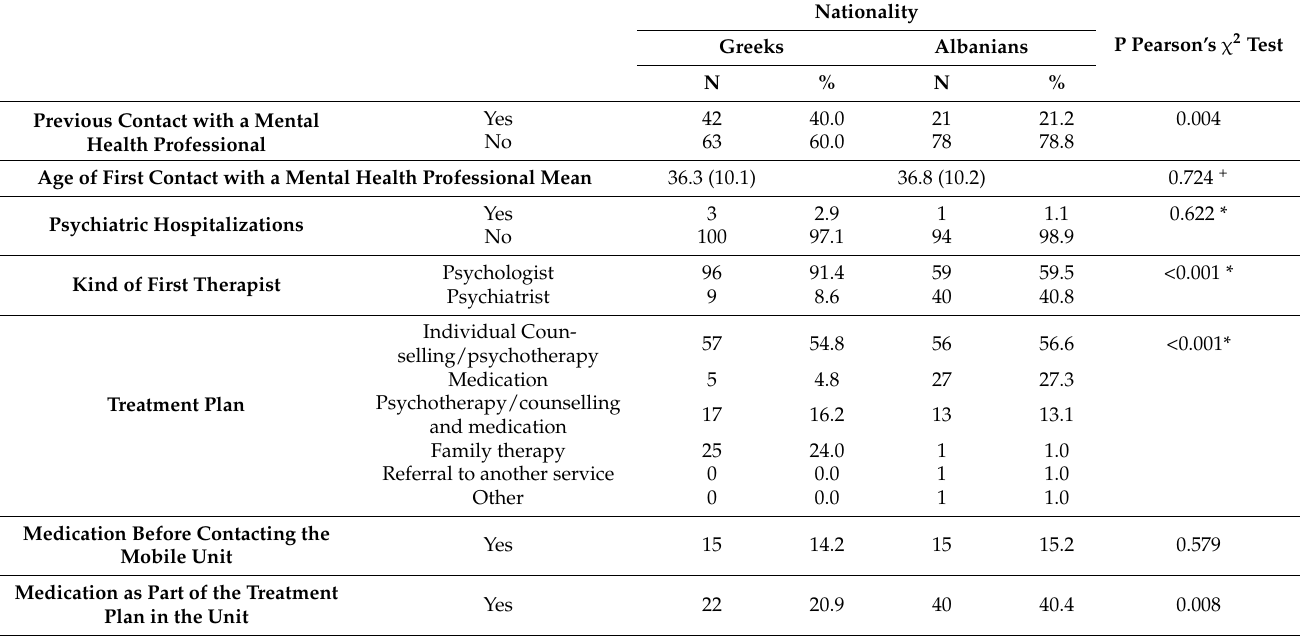
Table 4. Previous contact with mental health services and treatment